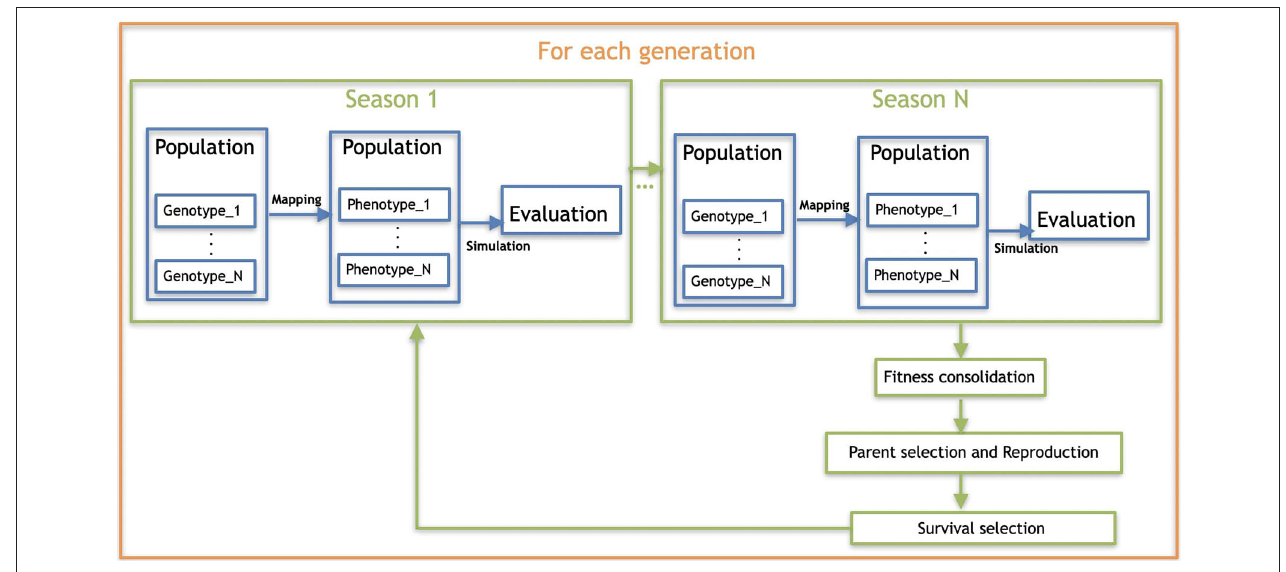
FIGURE 8 | Overall scheme of the evolutionary